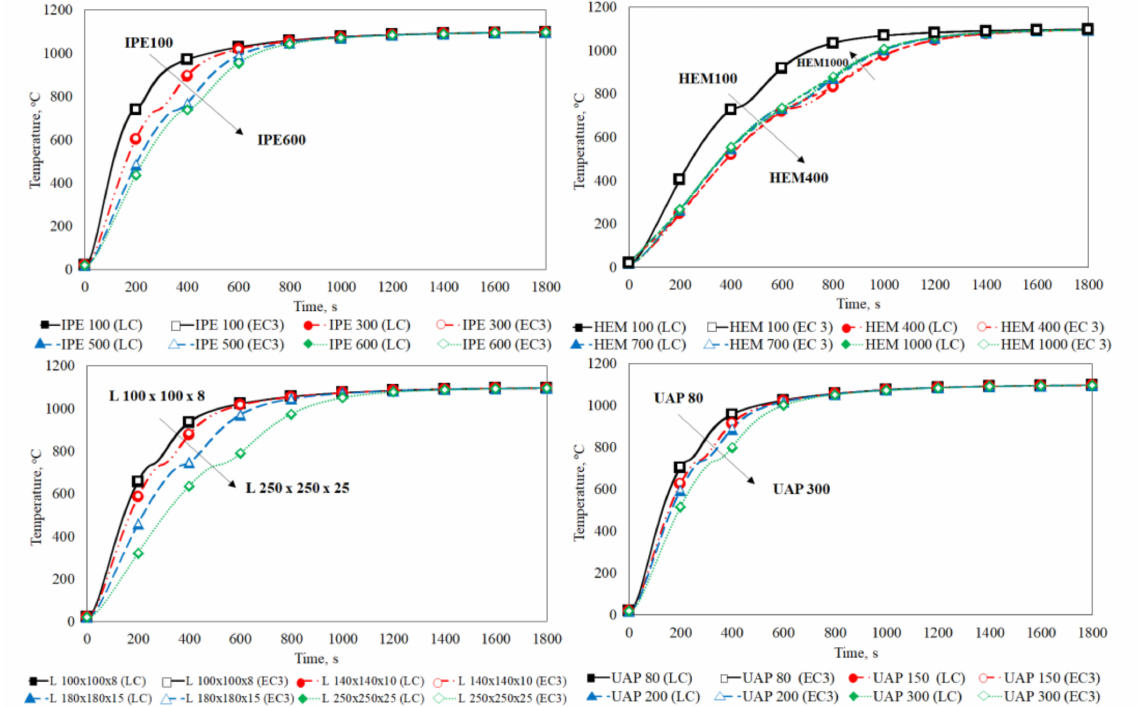
Figure 9. Temperature–time history of different profiles under hydrocarbon curve. LC and EC3 are in